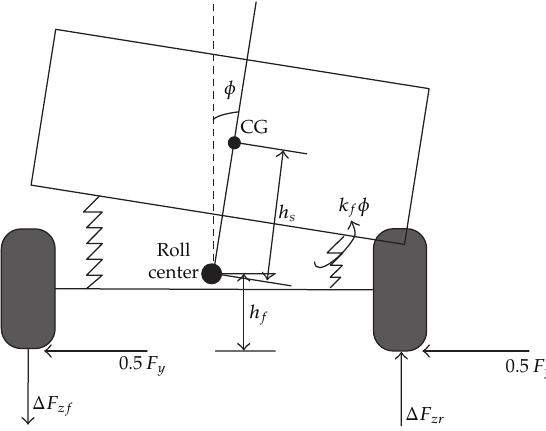
Figure 2: Roll plane model of